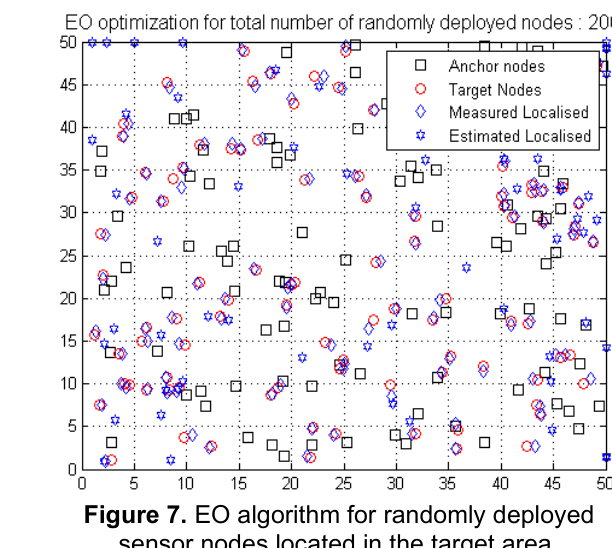
Figure 4. HHO algorithm for randomly deployed sensor nodes located in the target area .